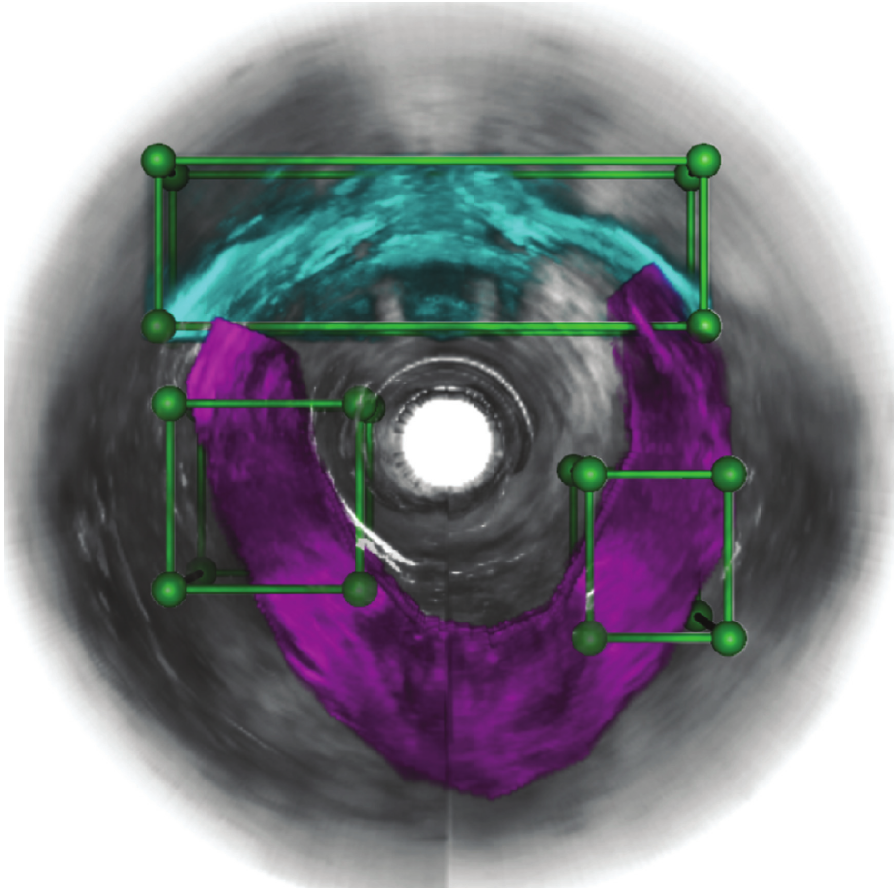
Fig 5. VOIs were defined near the pubic bone (cyan) and pelvic floor muscle (purple) regions. The green bounding boxes specified the volume of interests around the pubic bone (cyan) and pelvic floor muscle (purple).